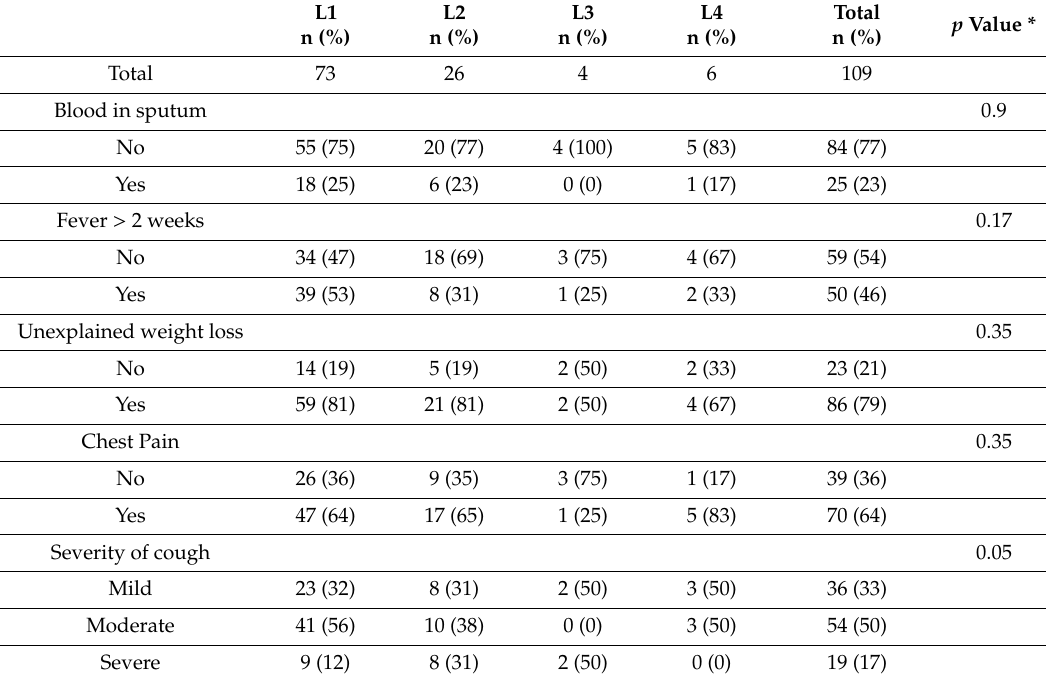
Table 4. The Clinical Characteristics of TB Patients and Major Lineages of Mycobacterium